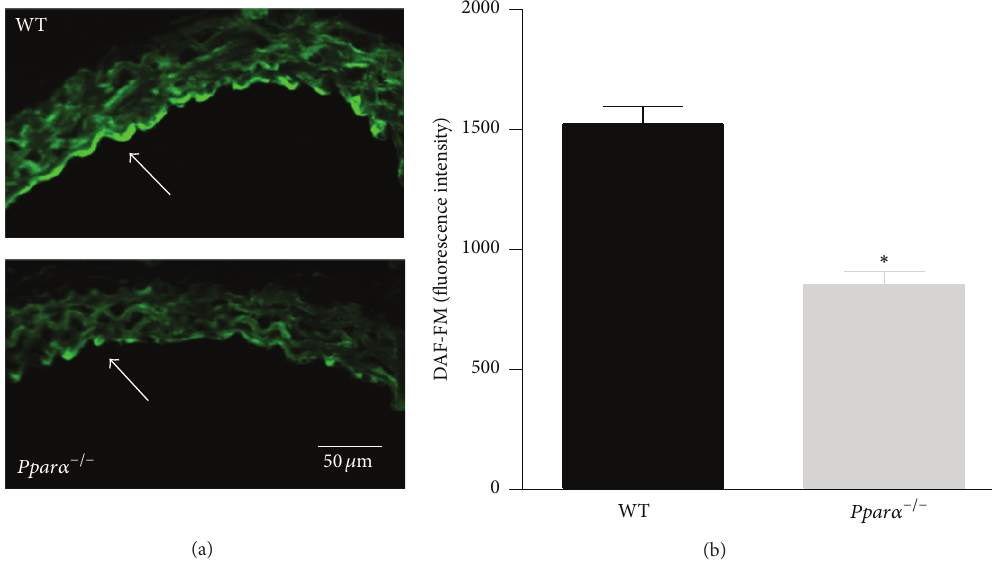
Figure 3: Decreased NO bioavailability in Ppar 𝛼 −/− mice. (a) Aortic rings from WT (top) and Ppar 𝛼 −/− (bottom) were sectioned and stained withDAF-FMtodetectNO.ThewhitearrowindicatestheendotheliallayerwherethereisincreasedfluorescenceinWTcomparedto Ppar 𝛼 −/− aorta. (b) Summary data of the DAF-FM fluorescence of the endothelial layer of WT and Ppar 𝛼 −/− aortas. ∗ denotes statistical significance from WT mice ( 𝑝 < 0.05 ; 𝑛 = 4 rings from 2 pairs of mice). Data are means ± SEM.